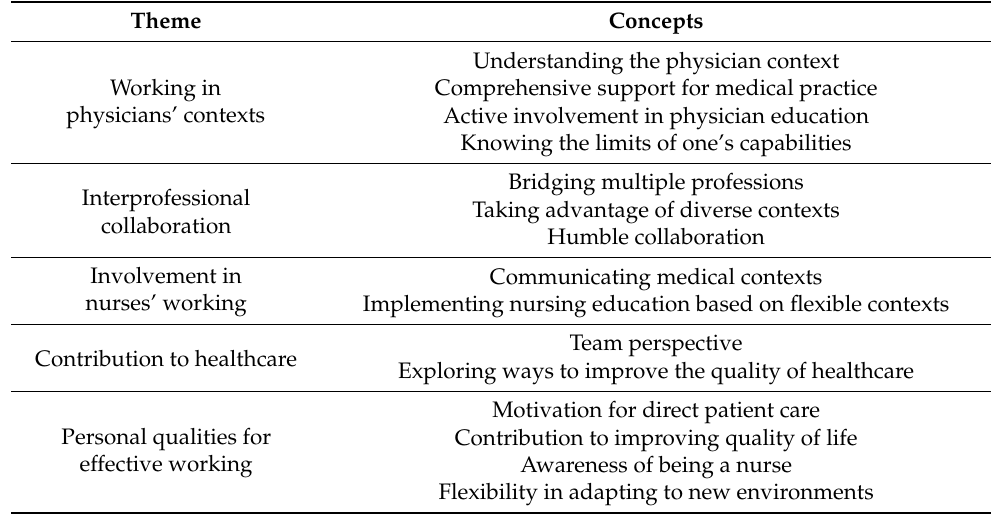
Table 1. Identified competencies and roles among Japanese expert nurse